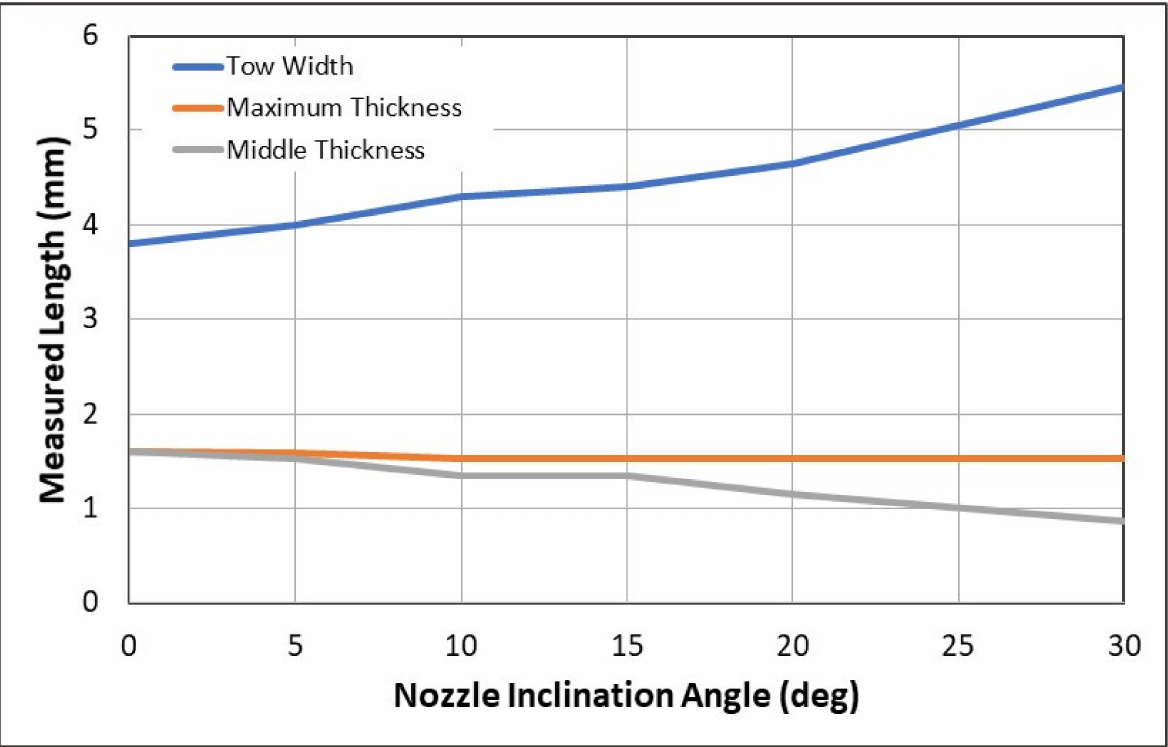
Figure 17. Change in thickness and width with Nozzle Inclination